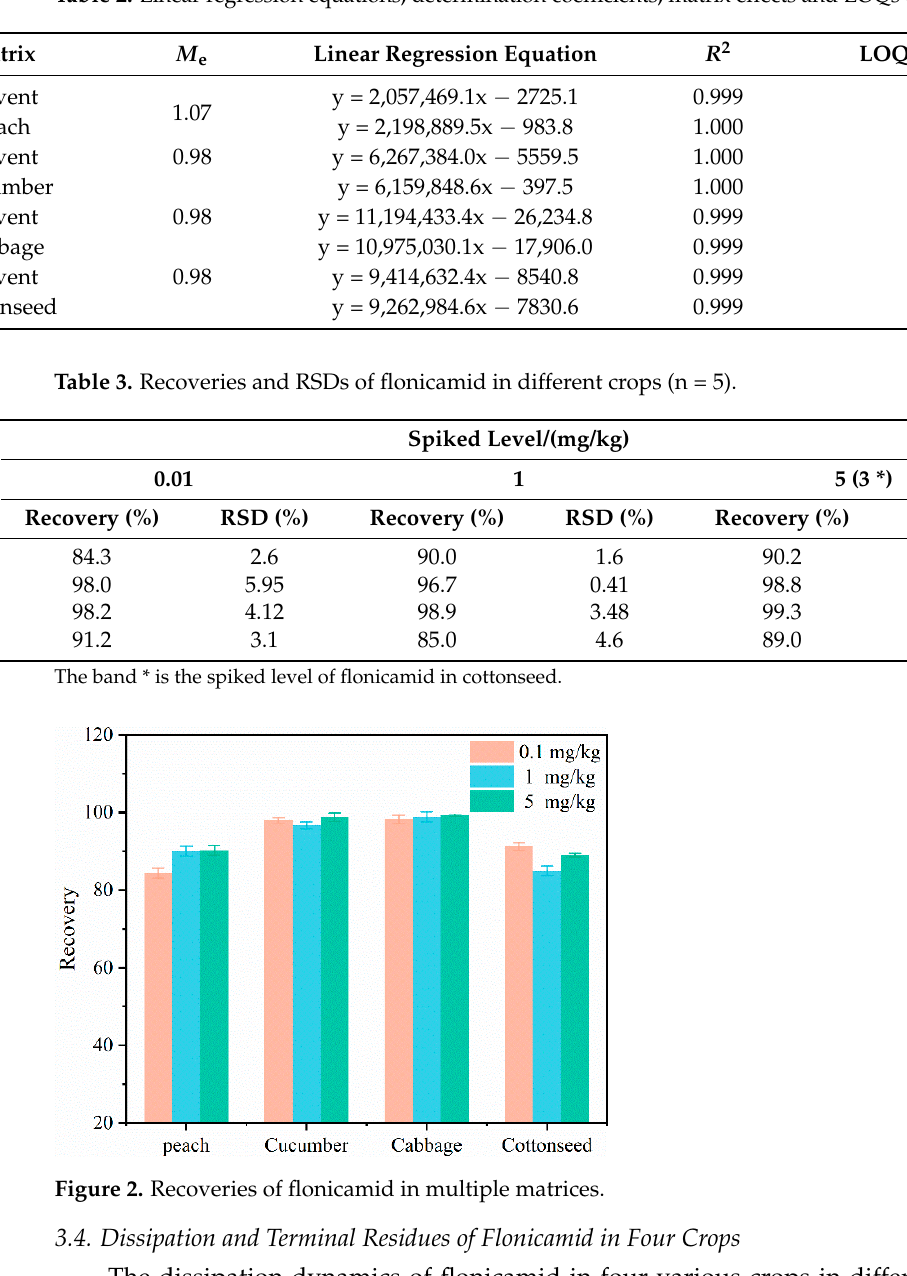
Table 2. Linear regression equations, determination coefficients, matrix effects and LOQs of flonicamid.